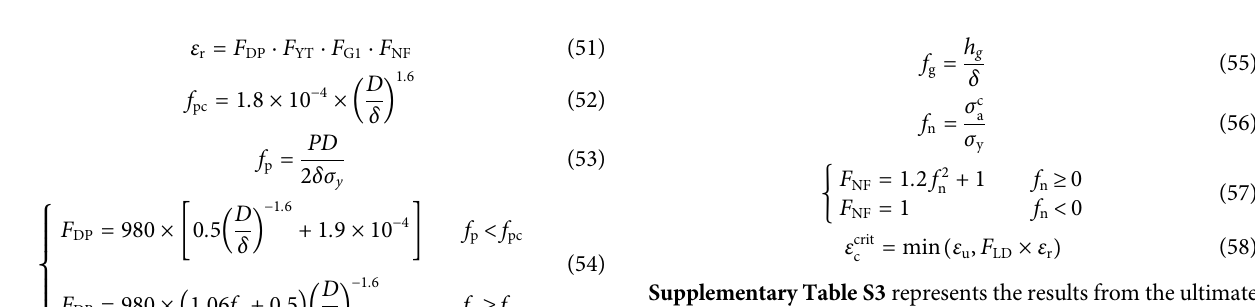
Supplementary Table S3 represents the results from the ultimate tensile strain parameters. The buckling strength ratio of the